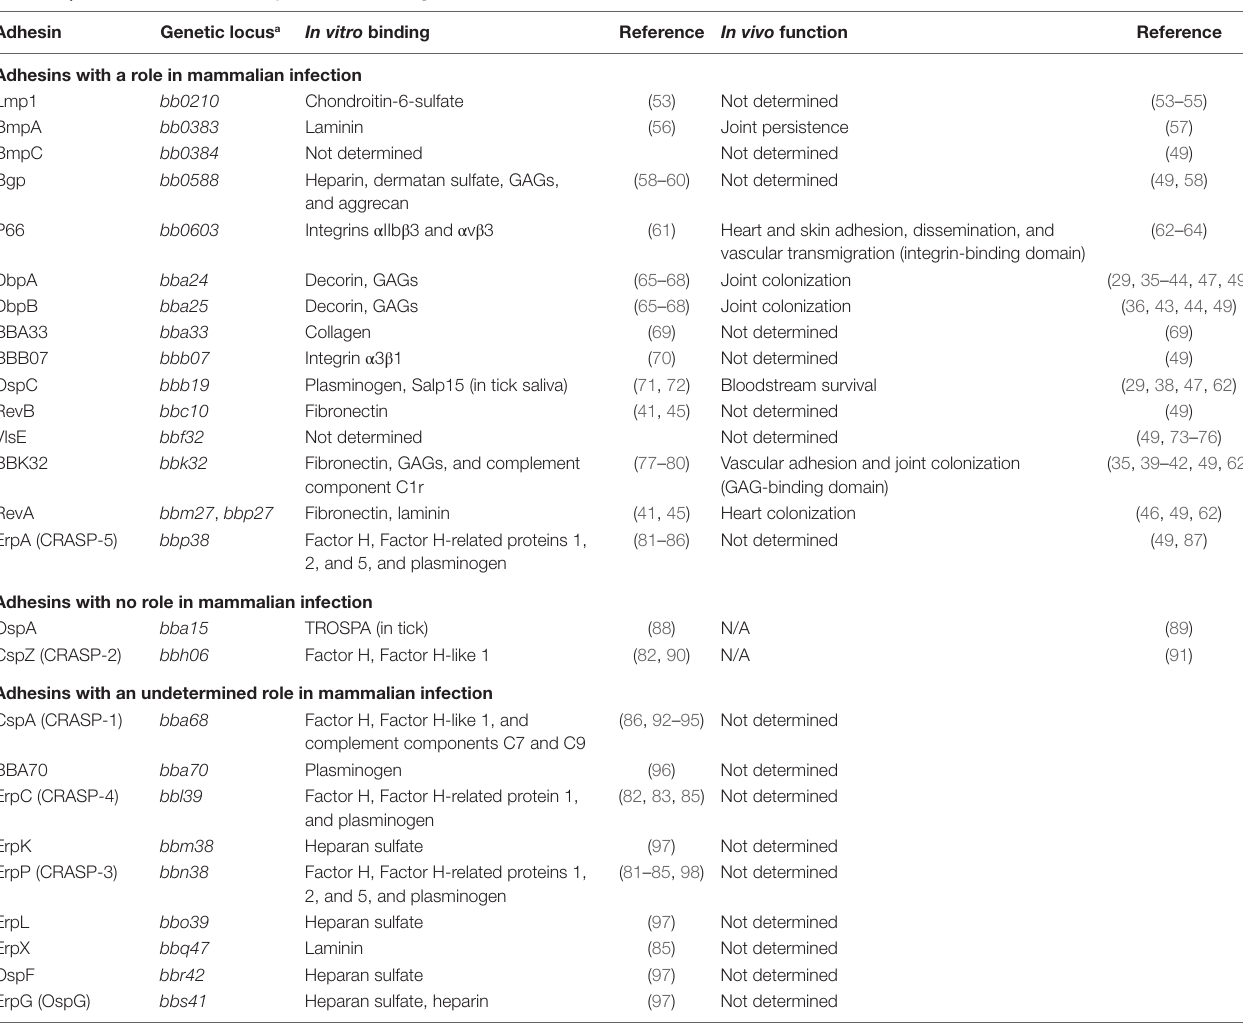
TABLe 1 | Adhesive outer surface proteins of B. burgdorferi .